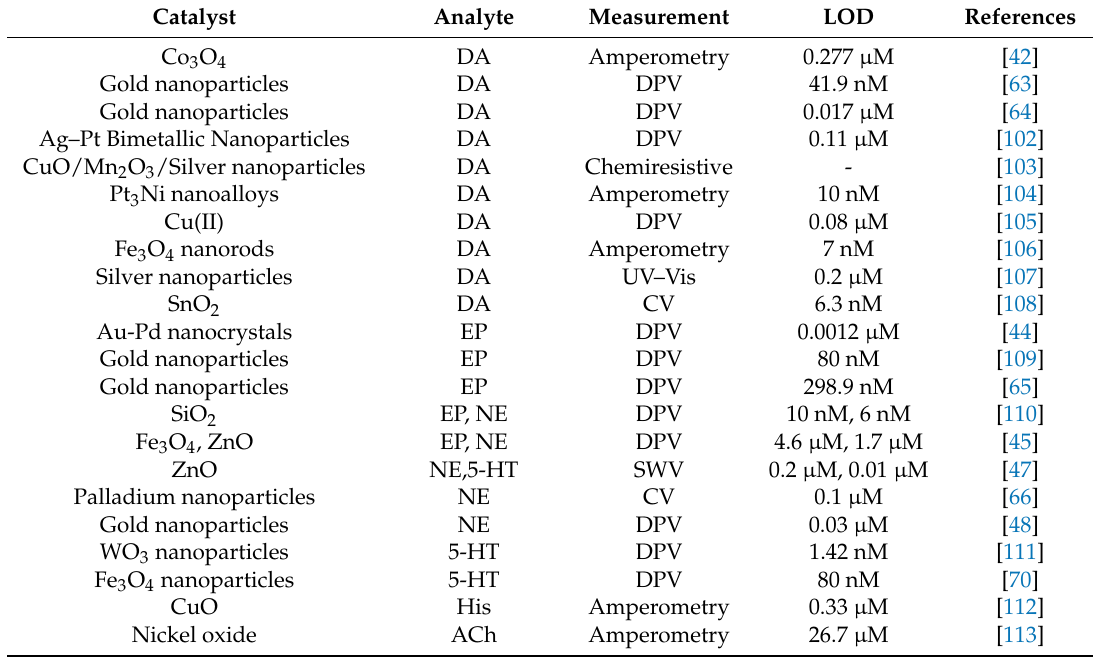
Table 5. Catalysts used in neurotransmitter